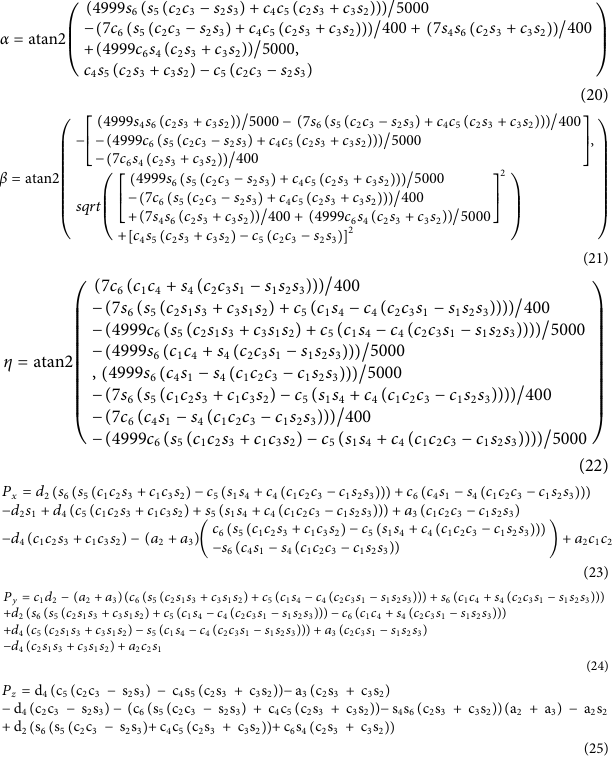
where s i (cid:2) sin θ i ( i (cid:2) 1 ~ 6 ) , c i (cid:2) cos θ i ( i (cid:2) 1 ~ 6 ) . a 2 , a 3 , d 2 , d 4 denotes the parameters of PUMA560 robot arm. g represents the initial position attitude matrix of the end-effector, T 1 ~ T 6 represents the variation matrix of the joint angles from 1 to 6, α , β , η represents Euler angles of rotation along the x , y , z axes after the end-effector moves from the initial position, and P x , P y , P z represents the new position of the end-effector after the end- effector moves from the initial position. The initial position pose matrix of the robotic arm end-effector in experiment 3, the associated change matrix and the three Euler angles of the end-effector, and the position expressions are shown below.